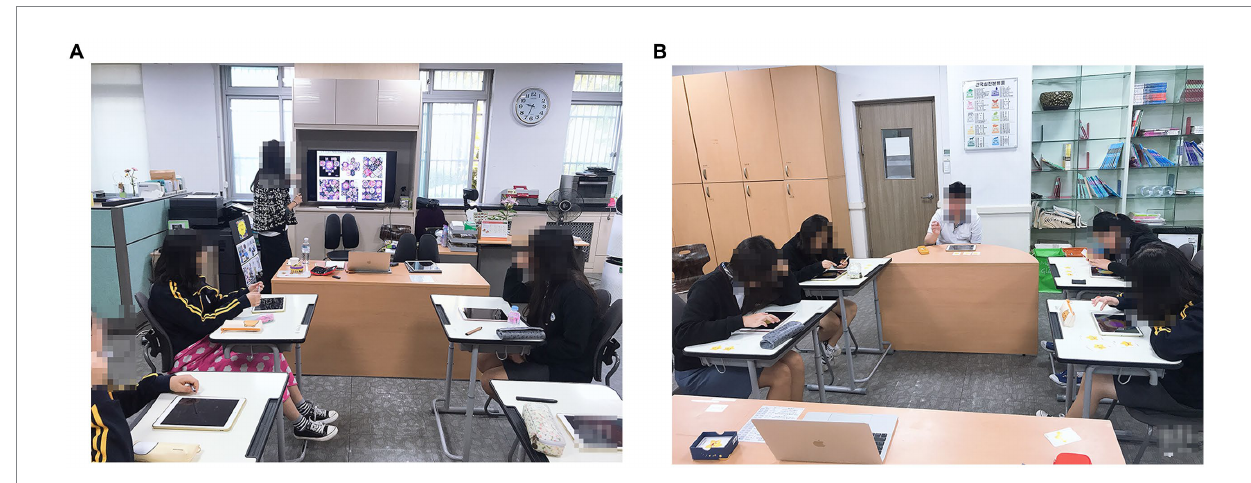
FIGURE 1 (A) Sharing of audio-visual materials. (B) 1:1 iPad art therapy